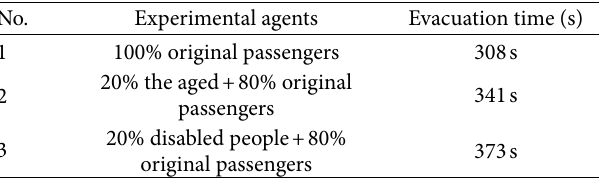
Figure 5: Number of agents passing through escalators/stairs. Table 3: Evacuation time for nonhomogenous